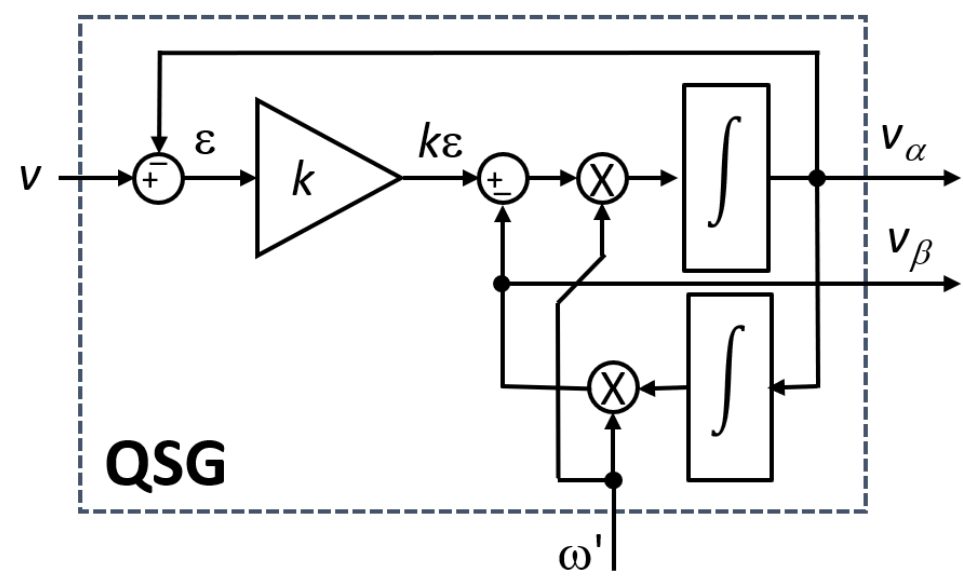
Figure 5. The second-order generalized integrator structure.